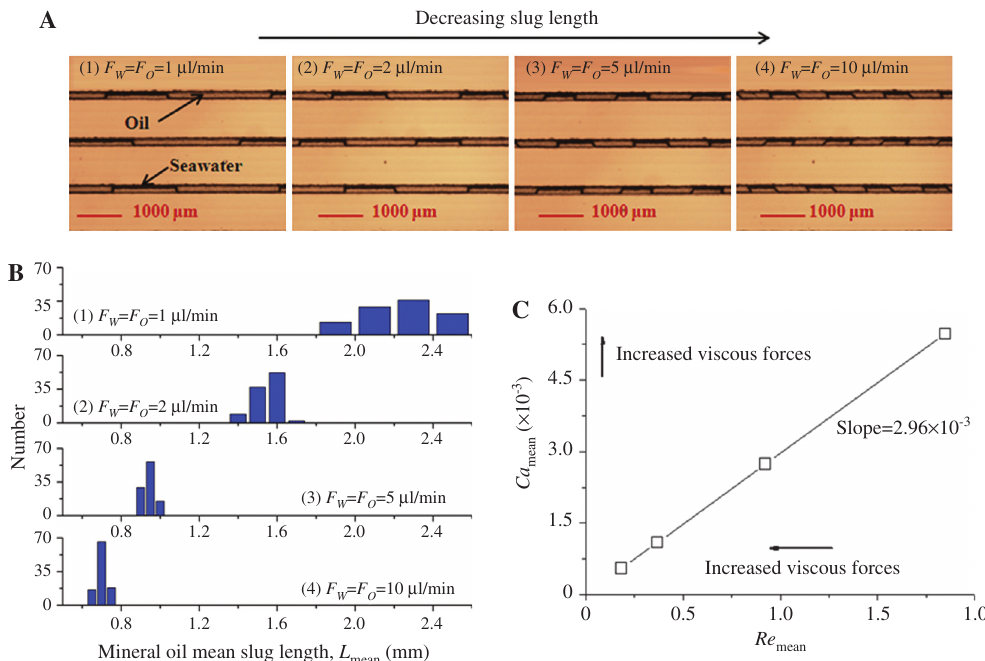
Figure 3 Characterization of mineral oil-seawater multiphase flow through a microfluidic device in the absence of dispersants. (A) Photo- graphs of mineral oil slug lengths obtained using a StereoZoom Microscope. (B) Estimation of the mineral oil slug length number distribu- tion at different injection rates. (C) Dimensionless characterization of the mean capillary and the mean Reynolds numbers.